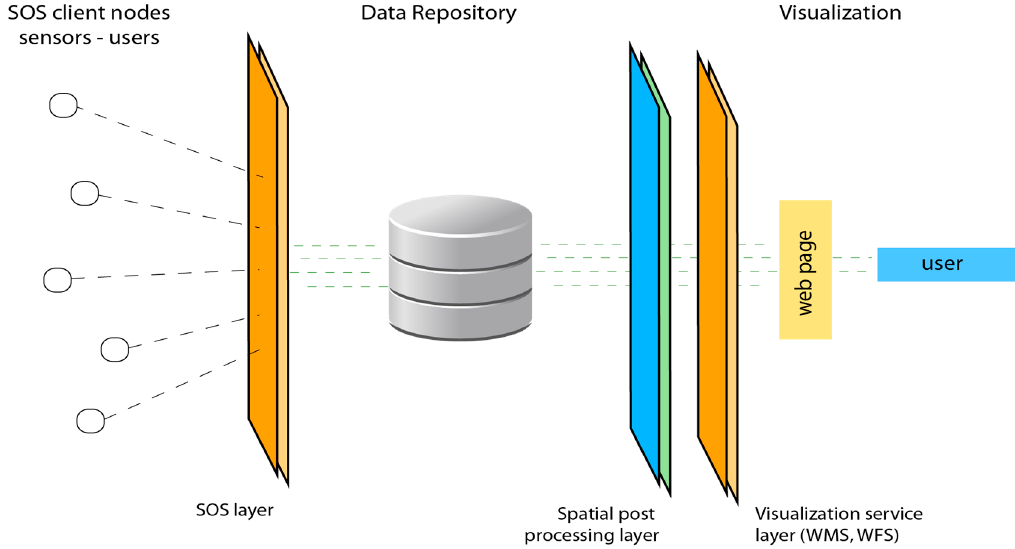
Figure 15. System architecture diagram. WMS, WFS Service layer.